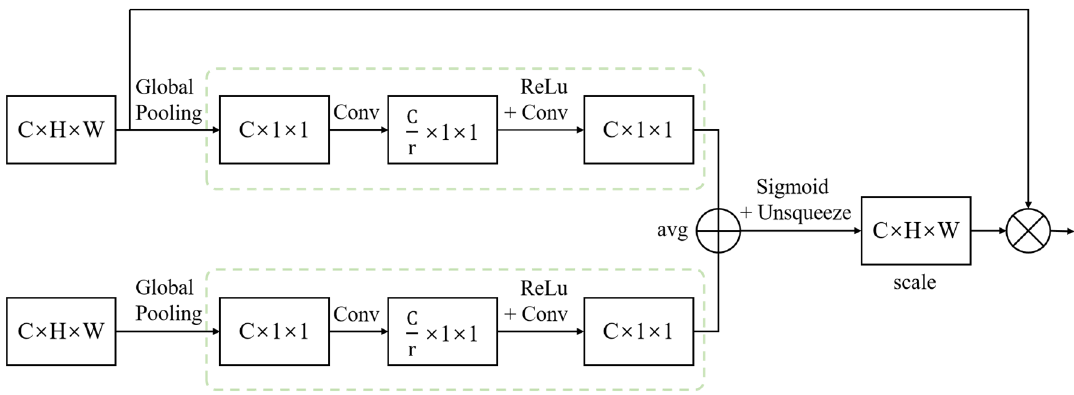
Figure 6. The architecture of Attention-based Squeeze and Excitation (ASE). In ASE, we conduct feature compression of O k and D k along the spatial dimension through a squeeze operation [48] to obtain the global receptive field. Spatial squeeze is performed by a global average pooling (GAP) layer: